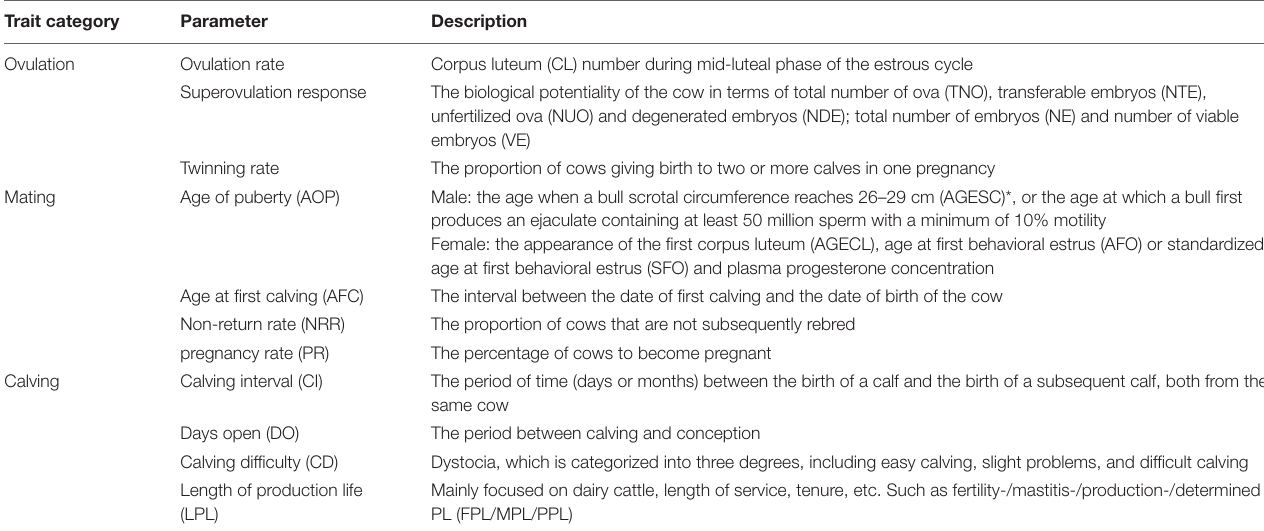
TABLE 1 | Physiological classification and description of reproductive